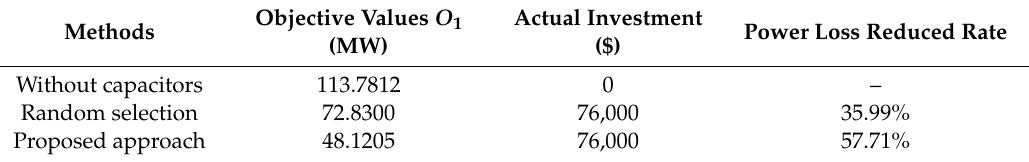
Table 5. Results for each candidate matter of M = 80,000 case on the IEEE 118-bus system.